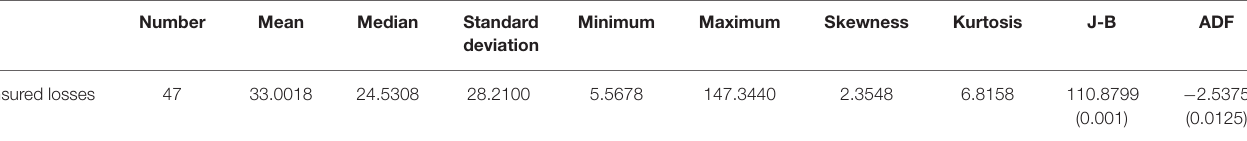
TABLE 4 | Descriptive statistics of global insured losses adjusted in 2016 prices from 1970 to 2016. Number Mean Median Standard